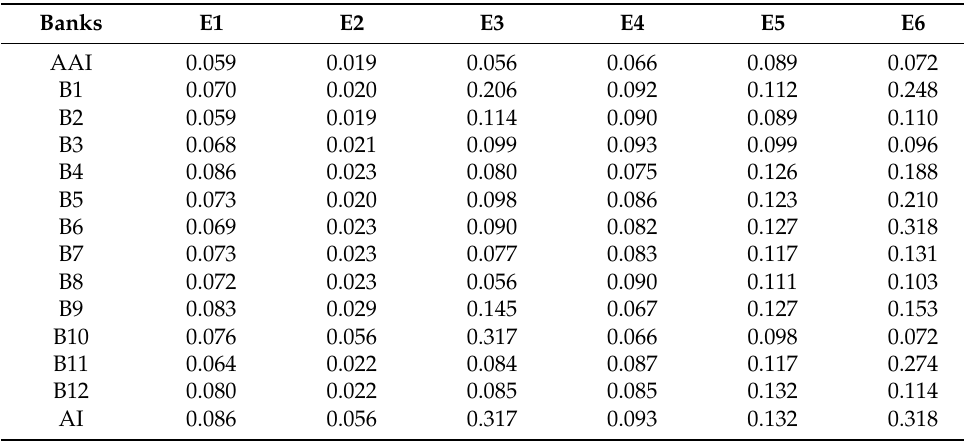
Table 14. The weighted matrix of bank efficiency for